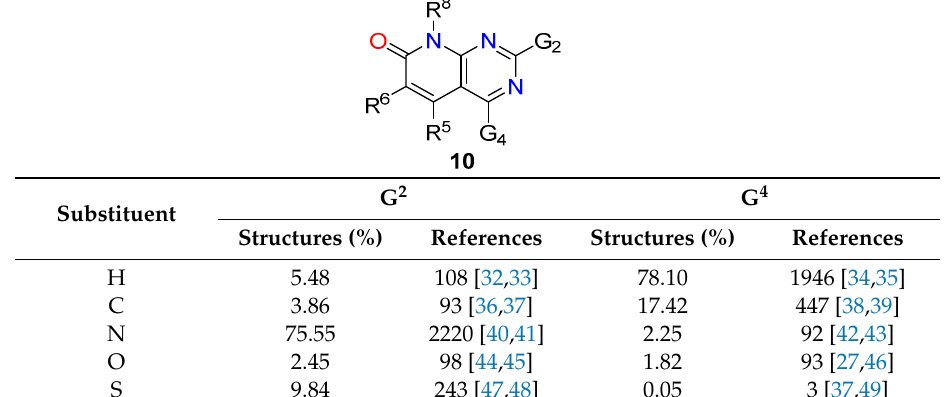
Table 2. Substitution pattern at C2 and C4 of pyrido[2,3- d ]pyrimidin-7(8 H )-ones ( 10 ) with a C5-C6 double bond.